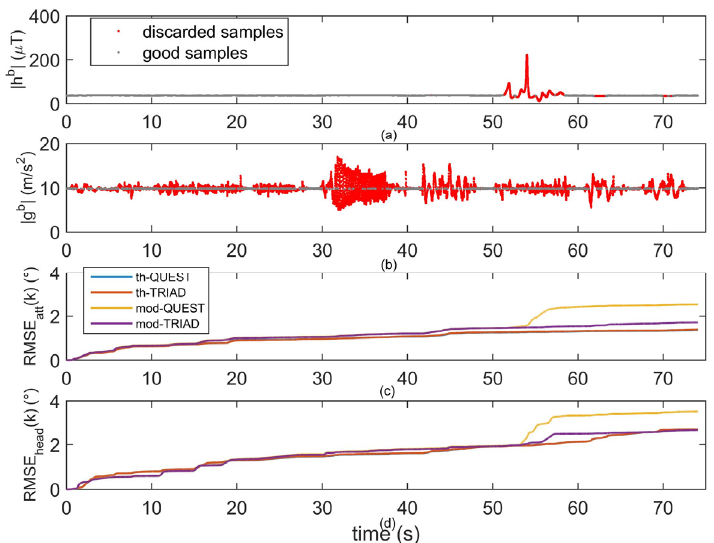
Figure 4. Comparison of the considered methods during the manual routines task: ( a ) norm of the sensed magnetic field; A magnetic disturbance is clearly visible when the sensor was approached to the magnet; ( b ) Norm of the acceleration measurements; ( c ) RMSE along the heading as a function of time for the four algorithms; ( d ) RMSE along the attitude as a function of time for the four algorithms. In ( a ) and ( b ), the samples accepted by the threshold-based algorithms are reported in gray, while the discarded samples are reported in red.